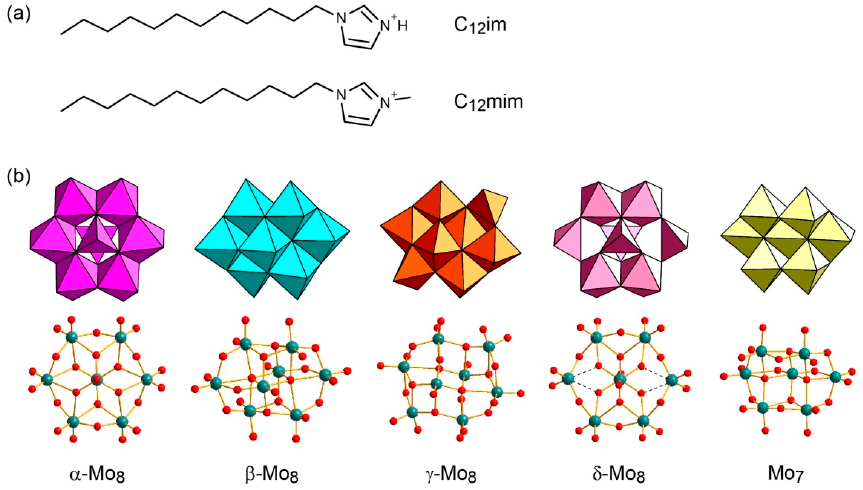
Figure 1. Molecular structures of ionic-liquid surfactants and polyoxomolybdates: ( a ) 1-dodecylimidazolium (C 12 im) and 1-dodecyl-3-methylimidazolium (C 12 mim); ( b ) Octamolybdate (Mo 8 ) isomers and heptamolybdate (Mo 7 ) in ball and stick (green: Mo, red: O) and polyhedral representations.